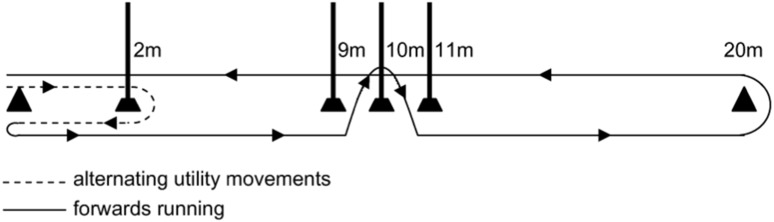
Schematic representation of the SAFT90 multidirectional running course.